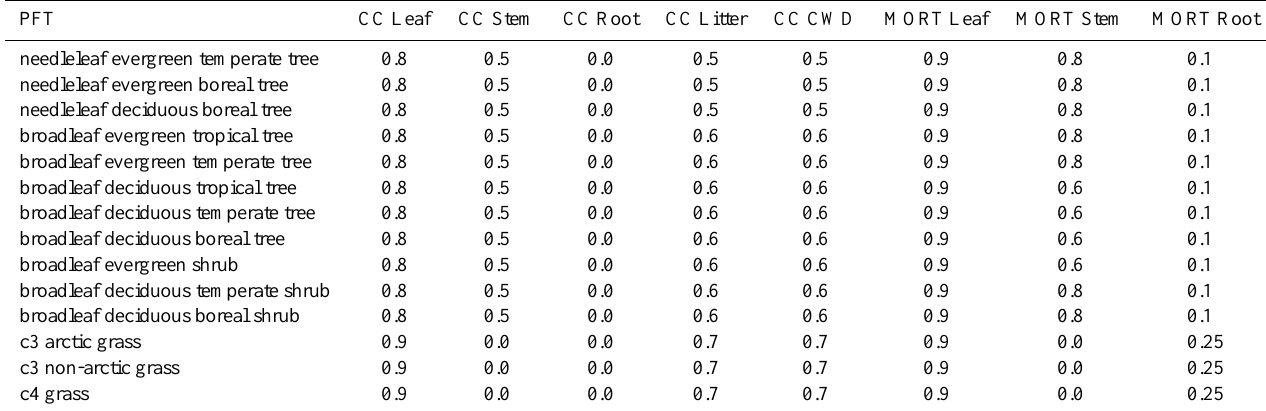
Table A2. Combustion Completeness (CC) and Mortality (MORT) factors for different plant functional types and fuel types after Arora and Boer